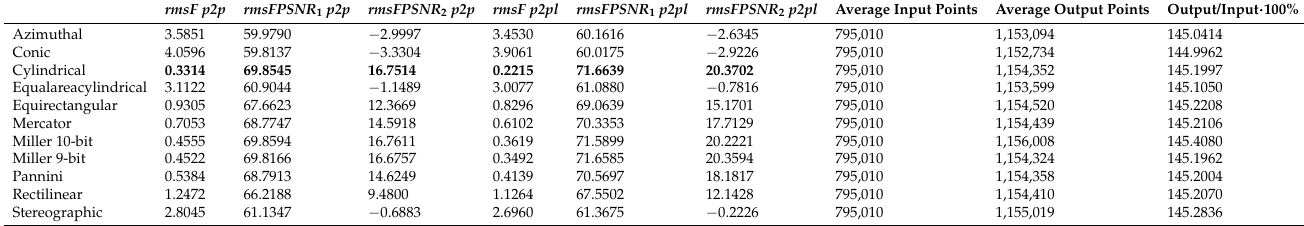
Table 9. Point-to-point (p2p) and point-to-plane (p2pl) objective measures rmsF , rmsFPSNR 1 and rmsFPSNR 2 , after Poisson reconstruction, using different projections with projection area of 1496 × 1344 pixels (approximately 2,000,000), best values are bold; average input and output number of points and their